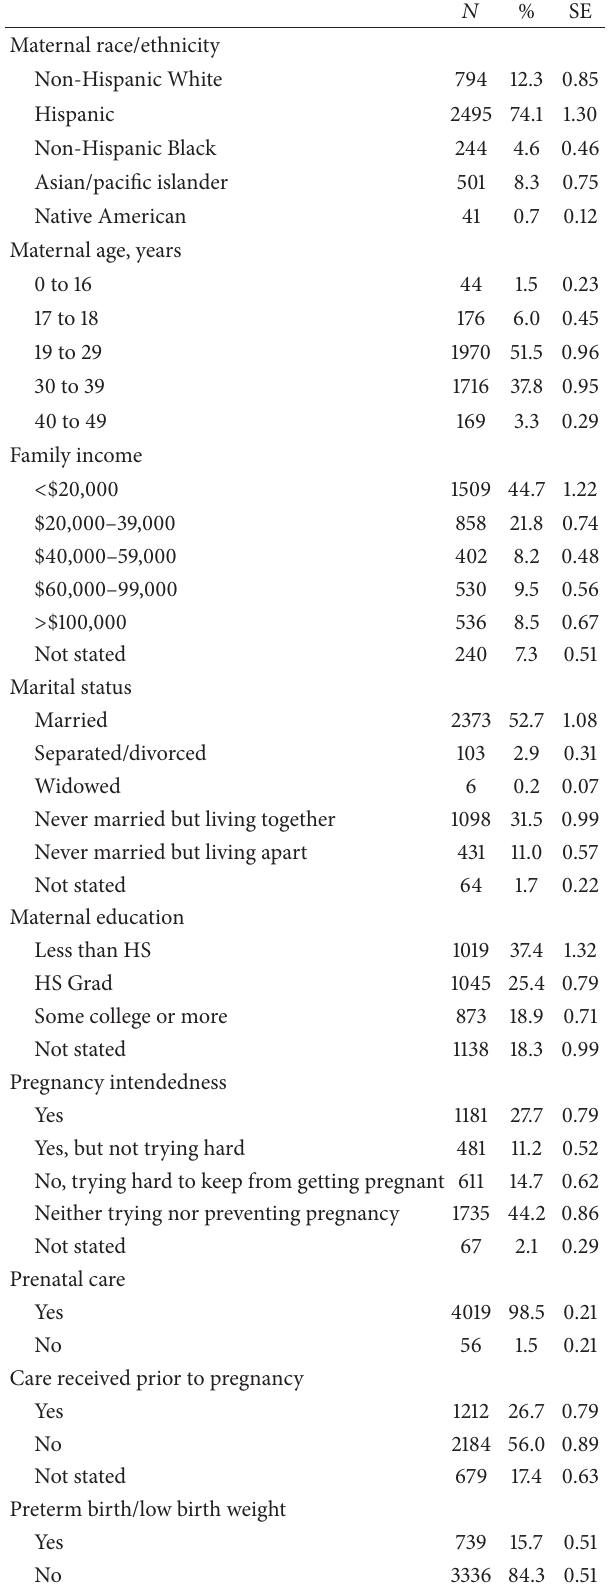
Table 1: Sociodemographic and maternal characteristics of study sample, 2007 LAMB ( 𝑁 = 4075